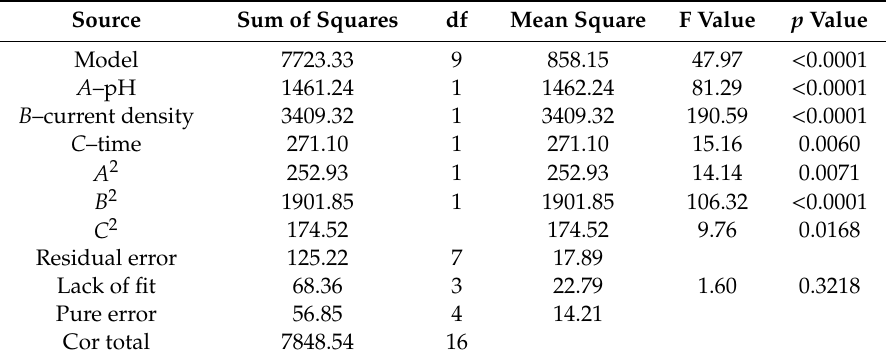
Table 5. Analysis of variance (ANOVA) response surface for COD ( Y 1